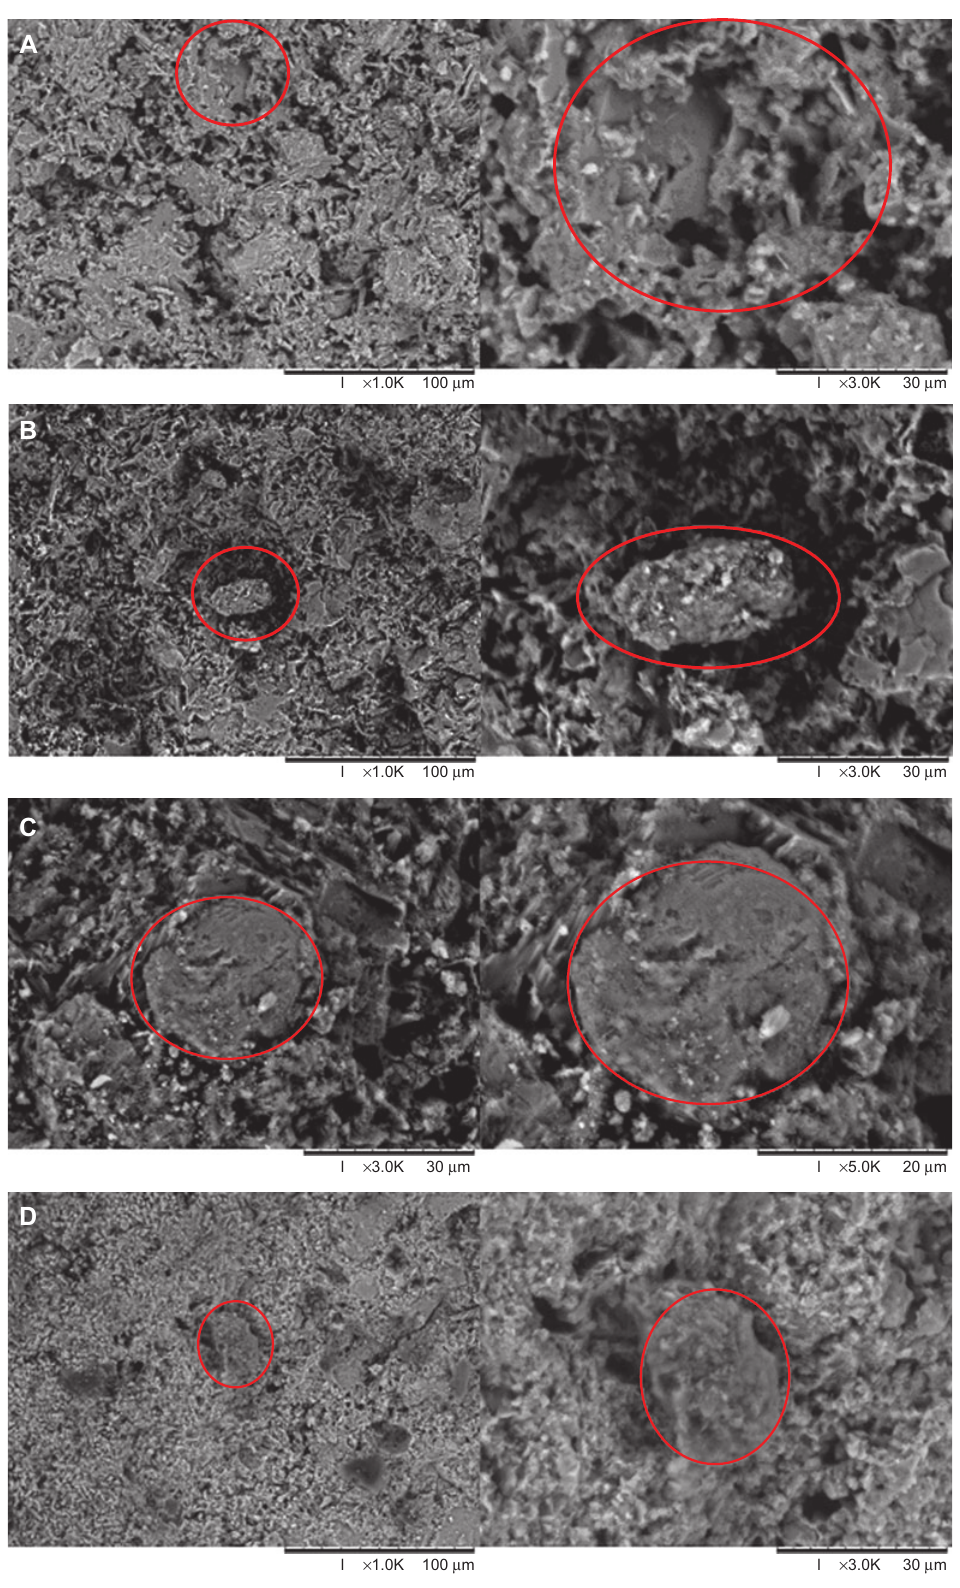
Figure 10 (A) SEM micrograph of cement paste without montmorillonite at 1K and 3K x; (B) SEM micrograph of cement paste with 5 % montmorillonite at 1K and 3K x; (C) SEM micrograph of cement paste with 10 % montmorillonite at 1K and 3K x; (D) SEM micrograph of cement paste with 15 % montmorillonite at 1K and 3K